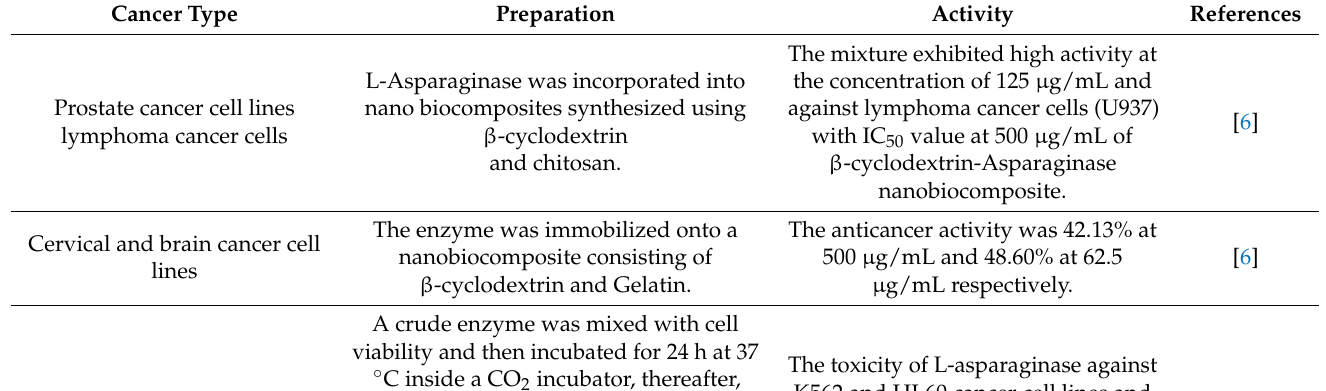
Table 7. Examples for the applications of L-Asparaginase as an